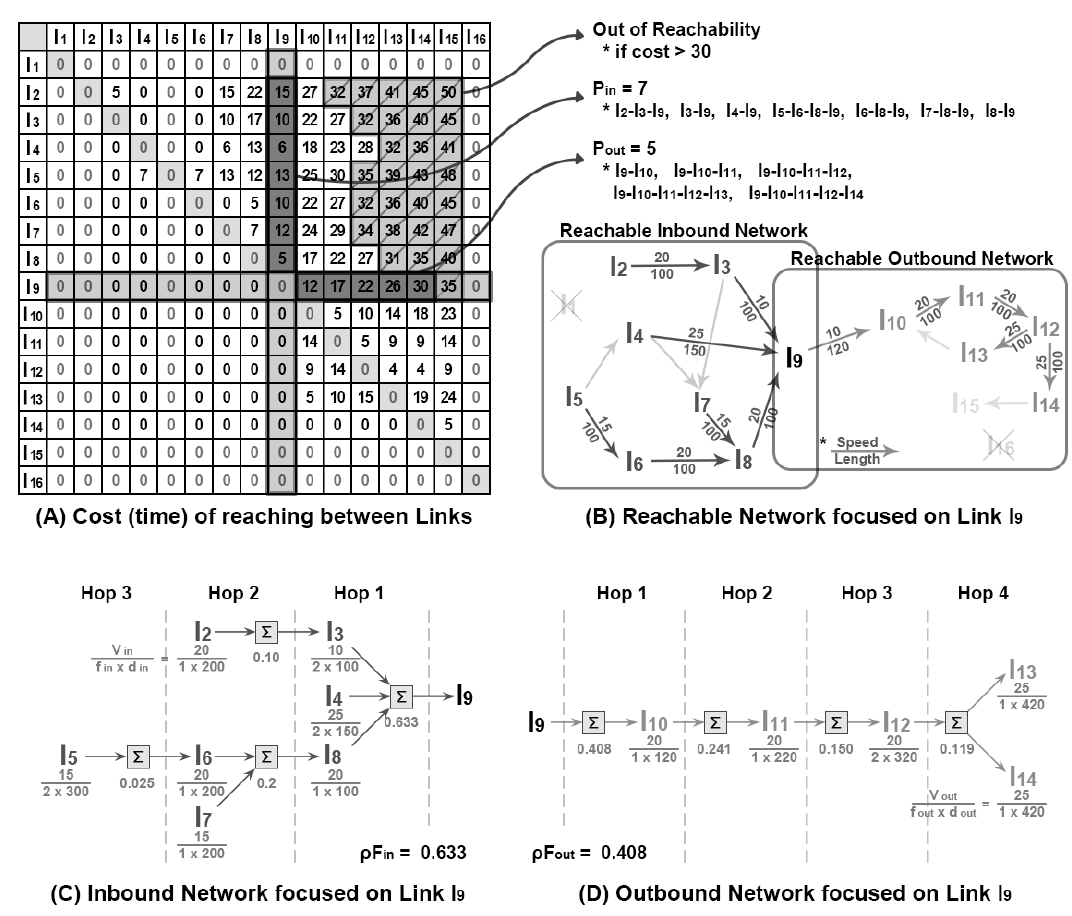
Figure 6. An example of aggregating the traffic conditions of the neighboring links on reachable